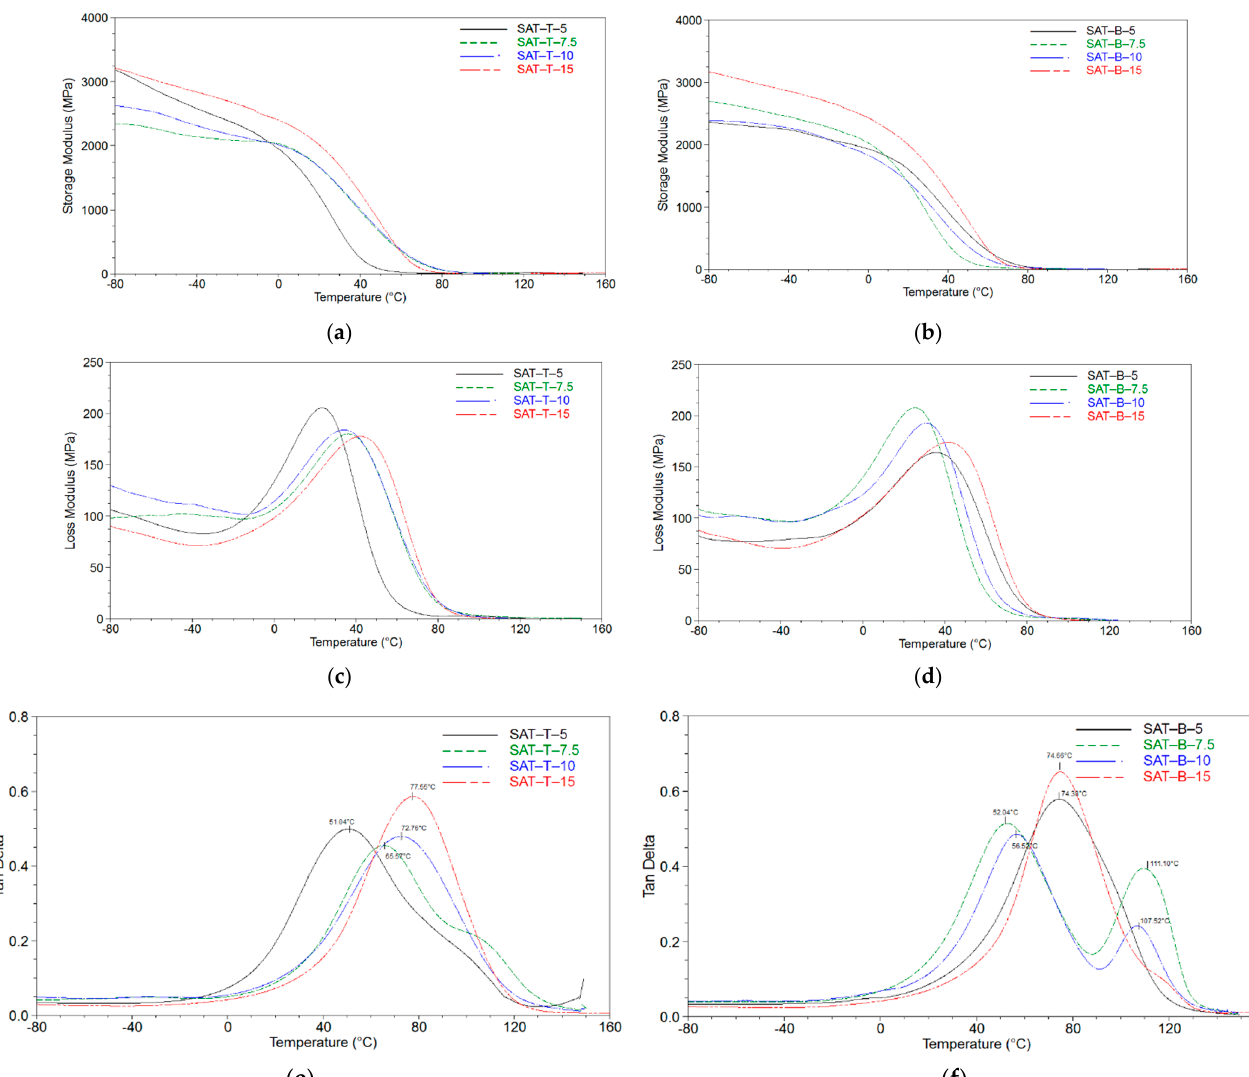
Figure 8. Storage module ( a , b ), loss module ( c , d ), and tan delta ( e , f ) for thermally cured SATs based on MATs.